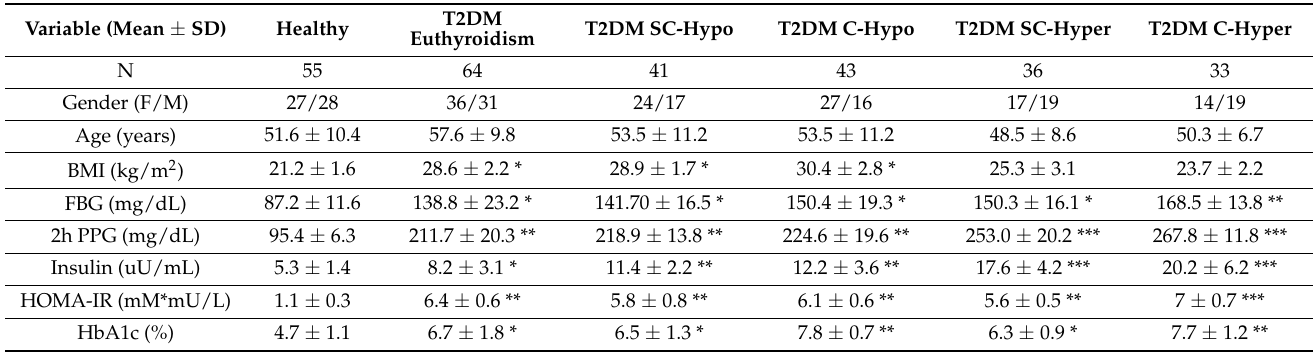
Table 1. Clinical and demographic data of studied